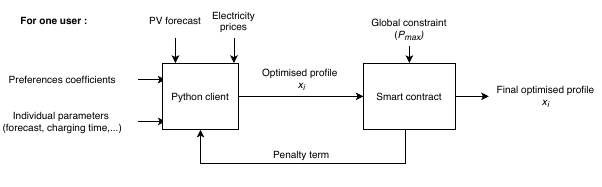
Figure 3. Optimisation for one